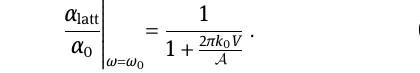
(cid:15)(cid:15)(cid:15)(cid:15) (cid:15)(cid:15)(cid:15)(cid:15) φ as (cid:15)(cid:15)(cid:15)(cid:15) (cid:15)(cid:15)(cid:15)(cid:15) φ